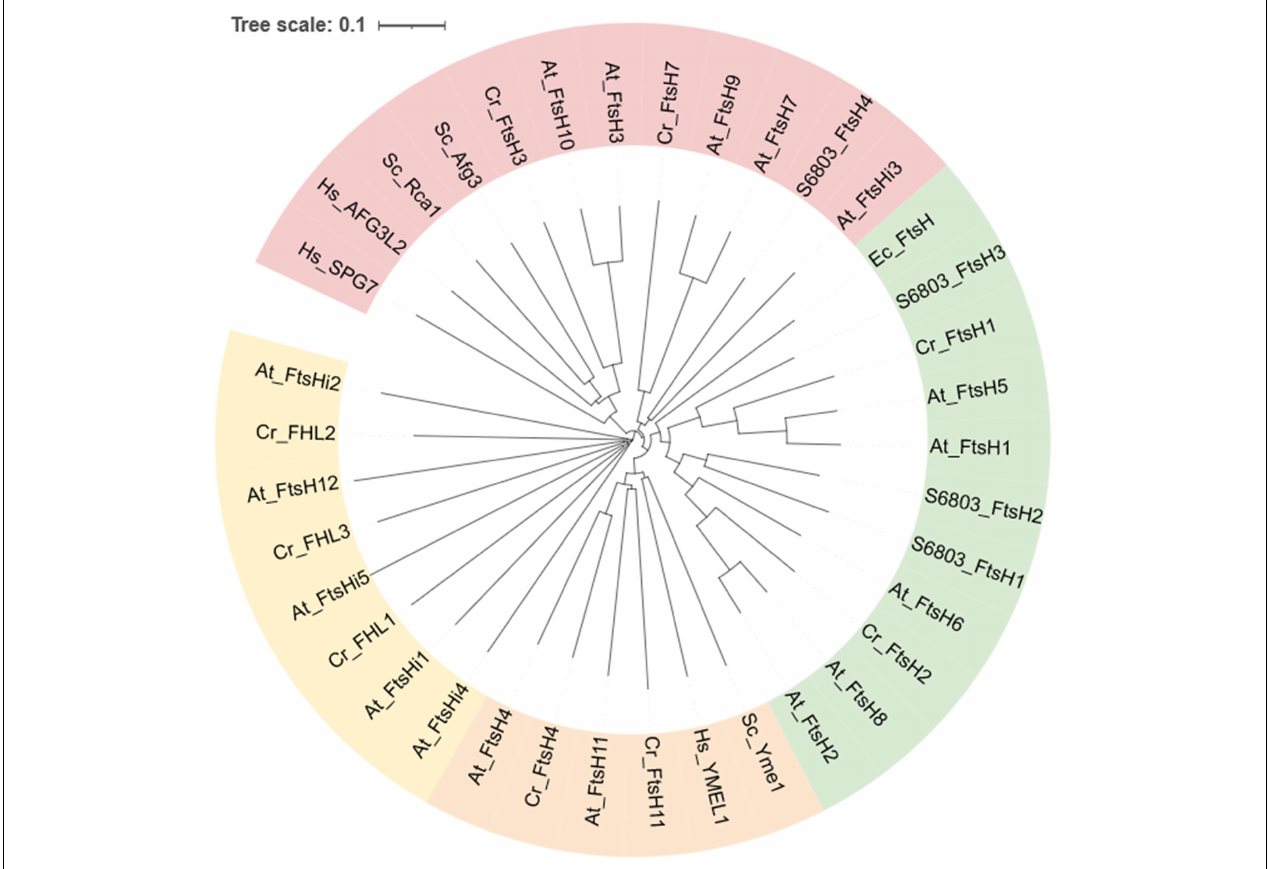
FIGURE 5 | Phylogenetic analysis of FtsH orthologs from selected species. Annotations are: FtsH from Escherichia coli (begins with “Ec”), Synechocystis sp. PCC 6803 (begins with “S6803”), Saccharomyces cerevisiae S288C (begins with “Sc”), Homo sapiens (begins with “Hs”), Chlamydomonas reinhardtii (begins with “Cr”), and Arabidopsis thaliana (begins with “At”). Homologs with pale-green background correspond to Group1, that of pink correspond to Group2, orange and yellow correspond to Group3 as designated in the Shao et al. (2018) article. The tree was generated using MUSCLE (https://www.ebi.ac.uk/Tools/msa/muscle/). The sequences of At_FtsH were obtained from Tair (https://www.arabidopsis.org/index.jsp), and that of Cr_FtsH were collected from Phytozome Chlamydomonas reinhardtii v5.6 (https://phytozome-next.jgi.doe.gov). The remaining sequences were collected from NCBI (https://www.ncbi.nlm.nih.gov/protein/). The information was accessed on November 10,